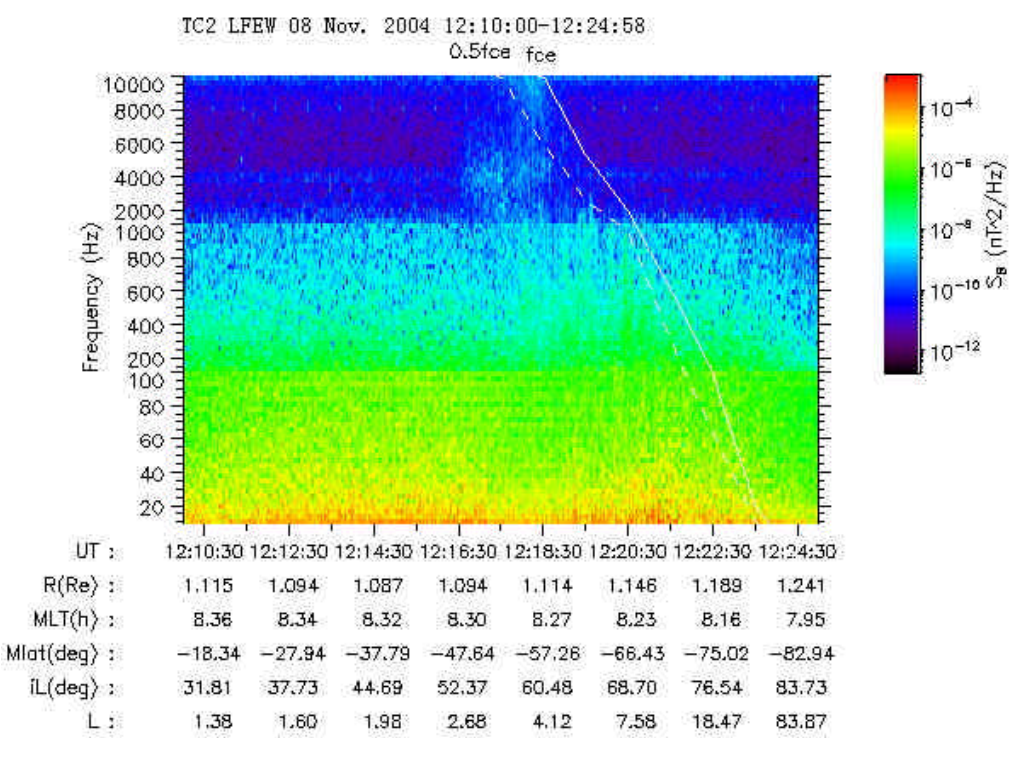
Fig. 9 Plasmaspheric hiss and mid-latitude hiss in the southern hemisphere observed by LFEW on Fig. 9. Plasmaspheric hiss and mid-latitude hiss in the Southern Hemisphere observed by LFEW on 8 November Nov.08, 2004.